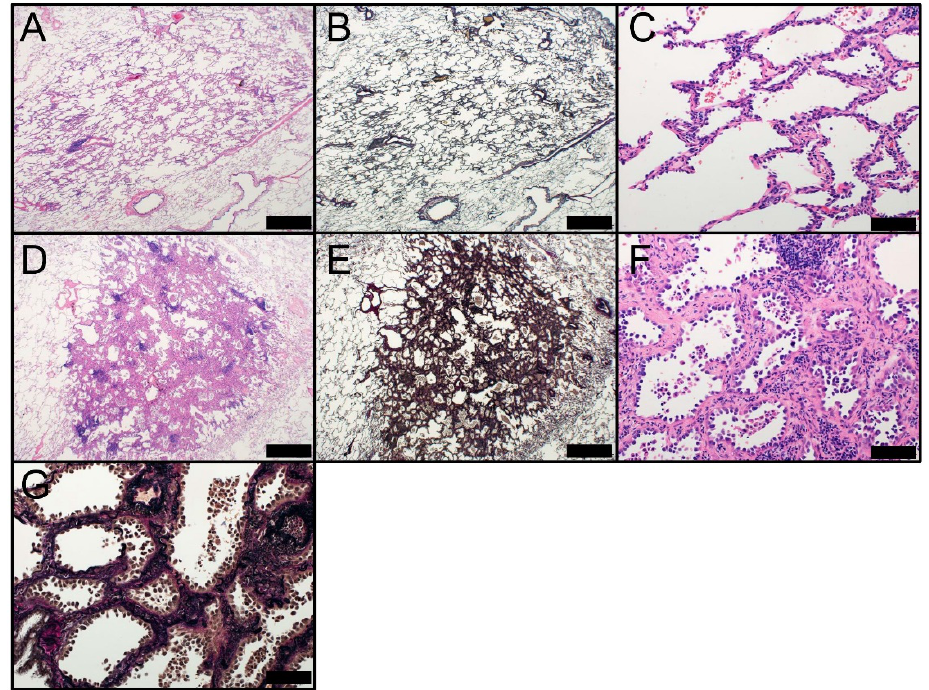
Figure 2. Morphology of AIS (Noguchi type A; A ‒ C ) and AIS, sclerosing type (Noguchi type B; D ‒